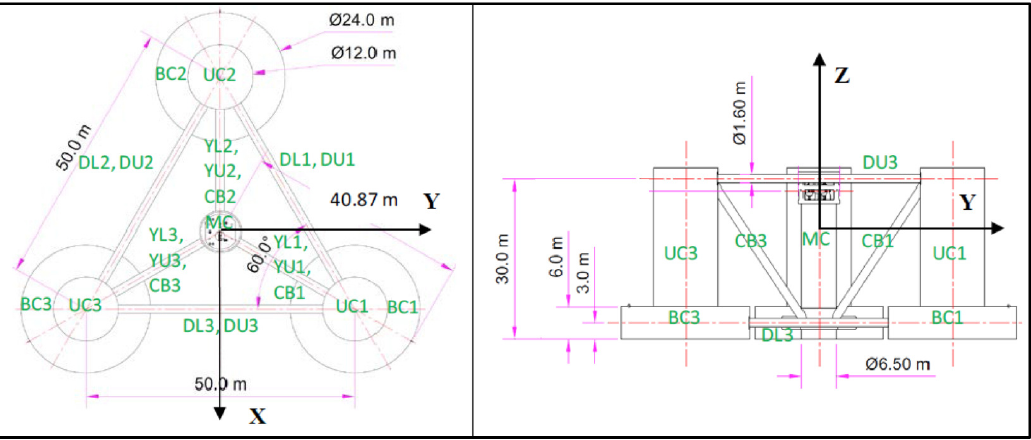
Figure 3. The OC4-DeepCwind semi-submersible platform: plan and